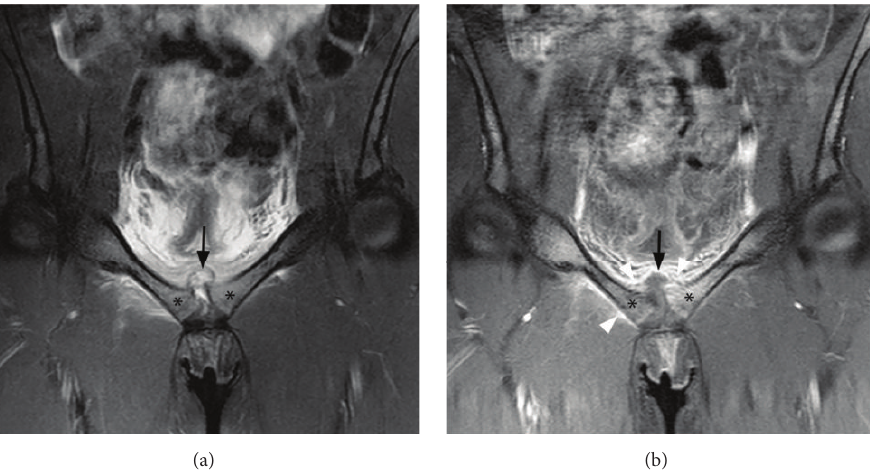
Figure 1: Corresponding coronal MR images of the pubic symphysis. (a) T2-weighted MR image with fat suppression showing bone marrow oedema in the pubic bones adjacent to the symphysis consistent with osteomyelitis (asterisk). A hyperintense fluid collection extending from the symphysis can be seen (black arrow). (b) T1-weighted MR image with fat suppression after intravenous Gadolinium administration showing marked contrast enhancement surrounding the hypointense fluid collection (black arrow) representing an abscess. There is also contrast enhancement representing inflammation in the surrounding soft tissues (white arrowheads) and within the pubic bones